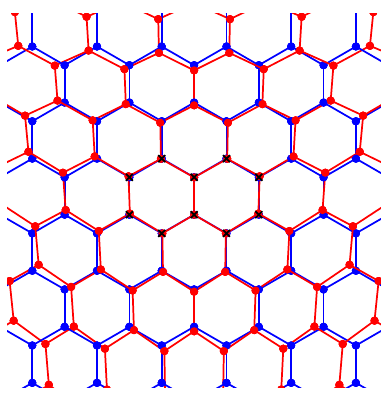
Figure 1: Sketch of the central region of the lattice. The undistorted honeycomb lattice is shown in blue, the strained lattice (with strain profile (32)) is shown in red. The 10 central sites that are used to calculate the LDOS are marked by a black